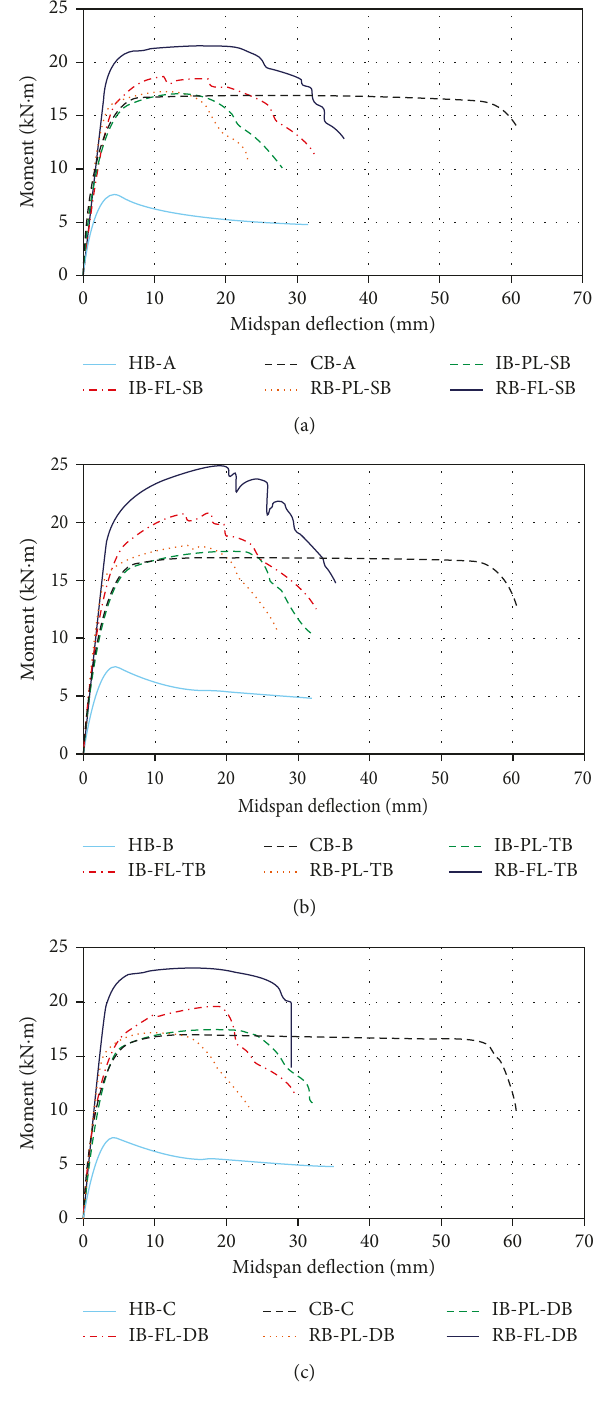
Figure 11: Moment versus midspan deflection curves. (a) Beams of group A. (b) Beams of group B. (c) Beams of group C. Figure 12 indicates that the preloaded beams followed exactly the same path of the control beams up to their predetermined loading stage. This response reflected the ability to conduct a healthy comparison between the ret- rofitted beams and their counterpart control beams. The preloaded beams were loaded up to an average bending